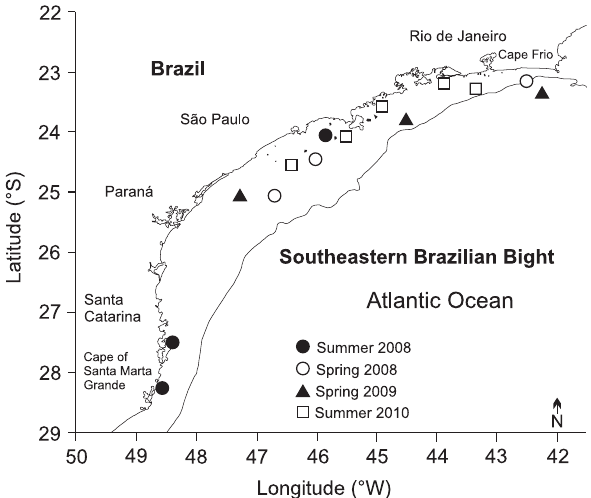
Figure 2. Map of the Southeastern Brazilian Bight (SEBB) showing the locations of fishing hauls with Trachurus lathami catches by period (n = 17, some points are overlapped in the map).